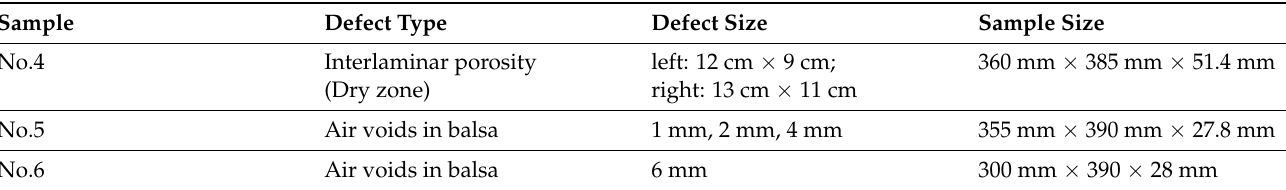
Figure 6. Illustration of defects within samples (left: interlaminar porosity, right: air voids in balsa). Table 5. Detailed specification of samples with